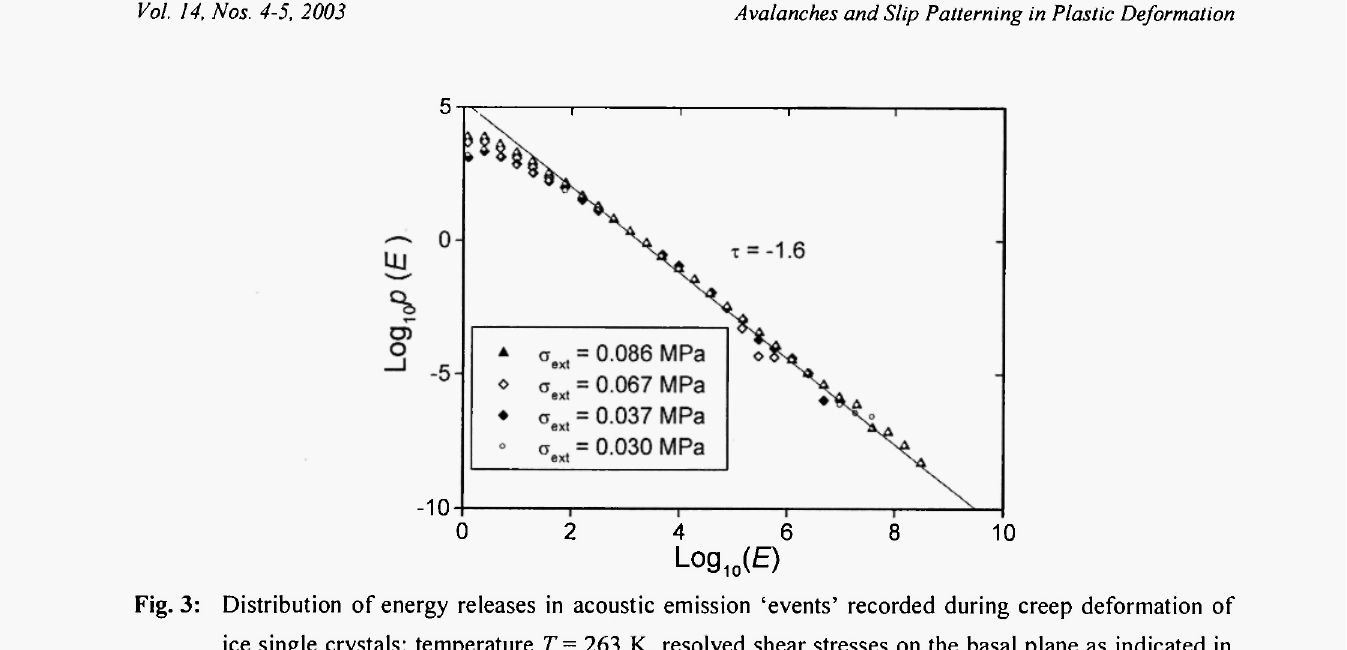
Hähner et al. /13,14/. While fluctuations in the flow stress (which can be related to inhomogeneities in the microstructure of the material) tend to make it deform heterogeneously on small scales, the regularizing character of the global hardening tends to smooth out the fluctuations on larger scales. By introducing a spatial coupling in the form of a gradient term one can provide for an additional interaction between adjacent volume elements which leads to spatial correlations in the slip pattern and to an avalanche-like dynamics. Plastic deformation in this case exhibits substantial spatio-temporal fluctuations on mesoscopic scales. It is shown in the following that the dynamics in this case exhibits strong analogies with physical systems